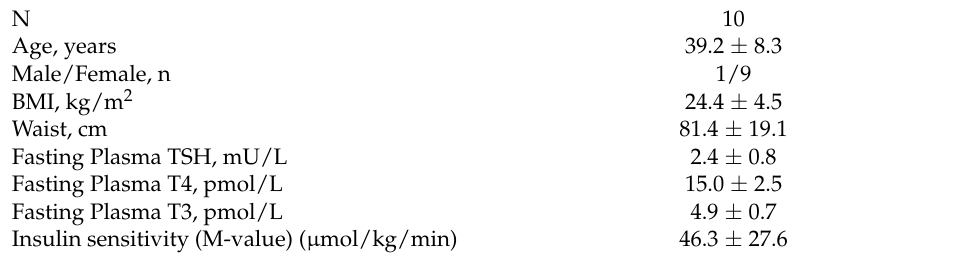
Table 1. Anthropometric Characteristics of Study